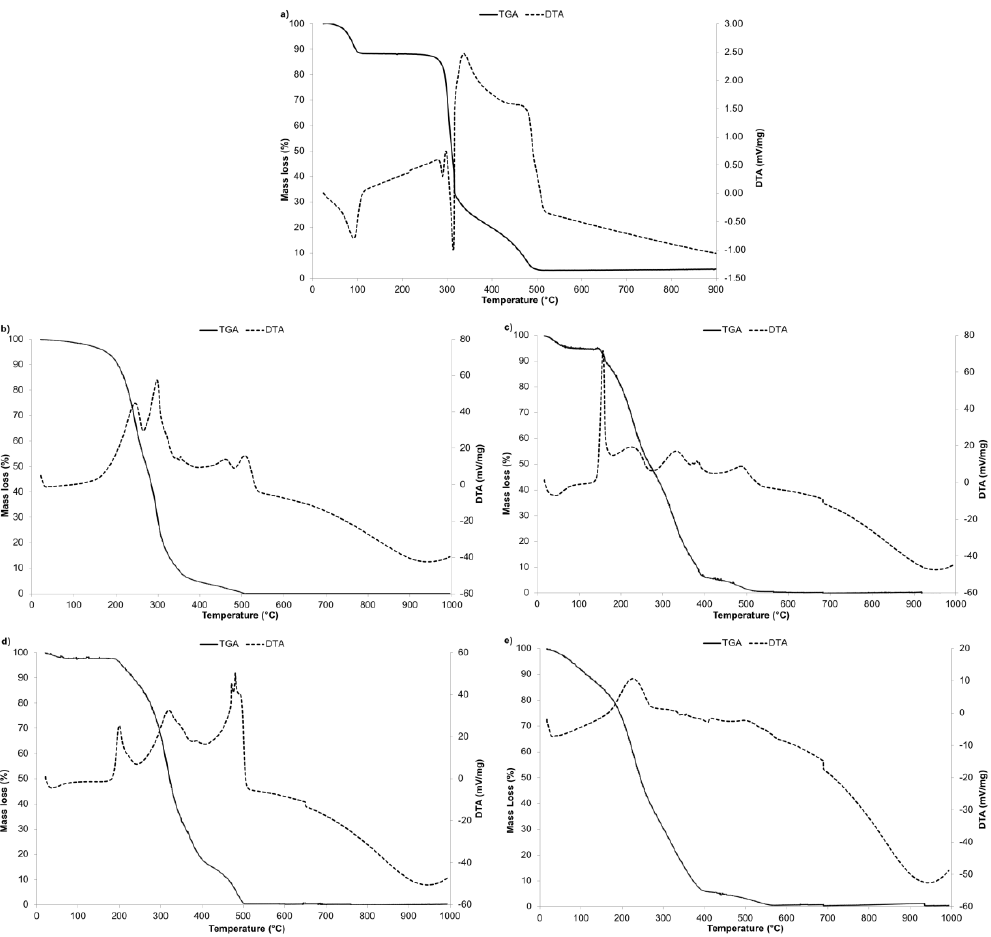
Figure 2. Thermogravimetric analysis (TGA) and differential thermal analysis (DTA) curves for ( a ) β - CD, ( b ) PEDGE, ( c ) EGCD, ( d ) PEGCD1 and ( e ) PEGCD2. β -CD, ( b ) PEDGE, ( c ) EGCD, ( d ) PEGCD1 and ( e )